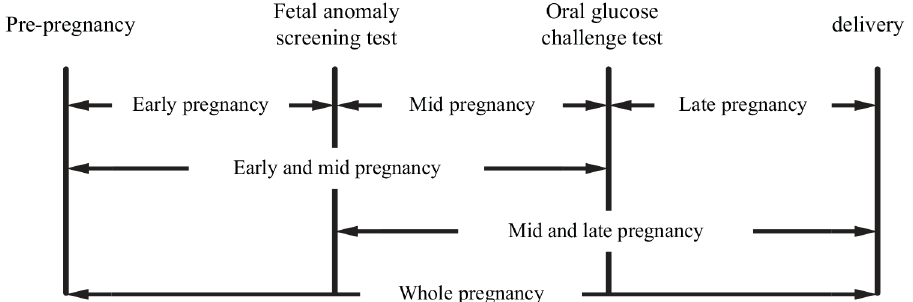
Fig 1. Times of weight measurement and pregnancy term definition. The rate of gestational weight gain (lb/week) was calculated for terms defined as followings: early pregnancy (from pre-pregnancy to fetal anomaly screening test), mid pregnancy (from fetal anomaly screening test to oral glucose tolerance test), late pregnancy (from oral glucose tolerance test to delivery), “ early and mid pregnancy ” (from pre-pregnancy to oral glucose tolerance test), “ mid and late pregnancy ” (from fetal anomaly screening test to delivery), and